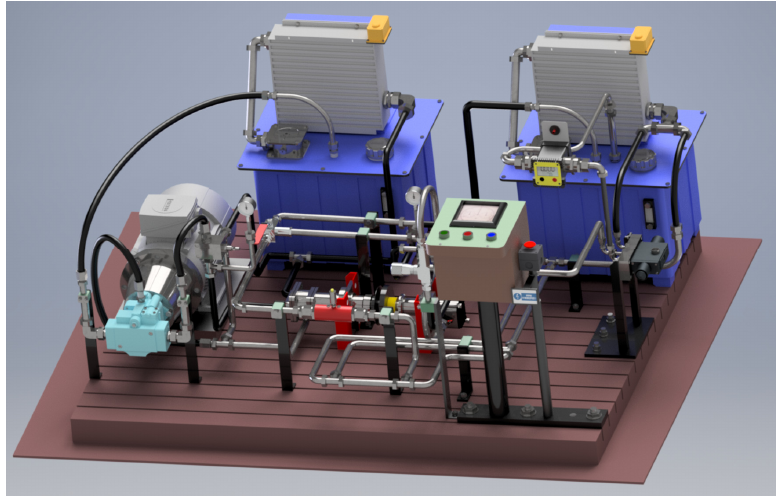
Figure 3. Test equipment for measuring the parameters of hydrostatic transducers. Table 12. Basic dimensions of the proposed device.